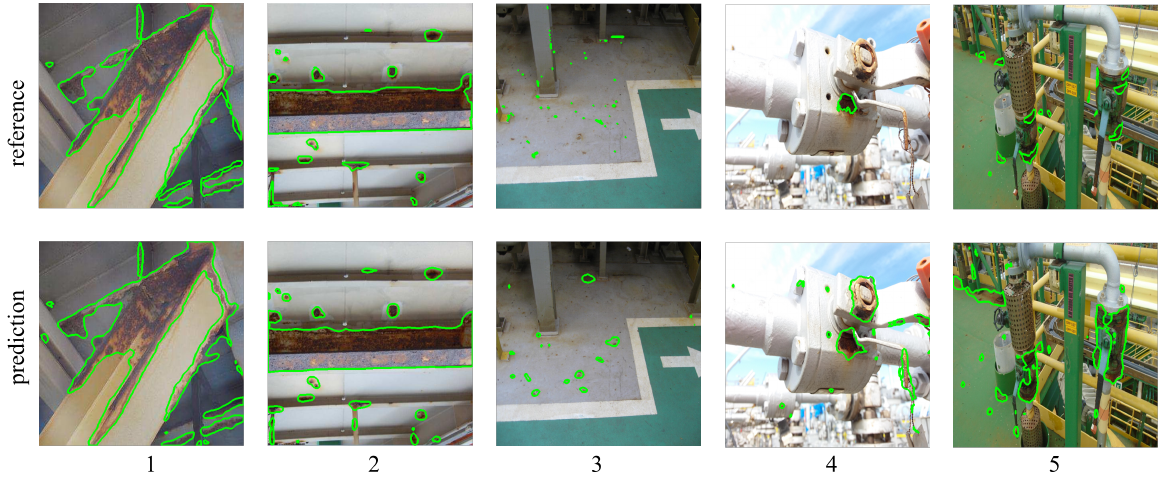
Figure 6. Sample images: reference segmentation (upper row) and example of prediction (lower row) The average f1-score is given by the arithmetic mean of f1- scores computed for the corroded and for the not corroded classes.